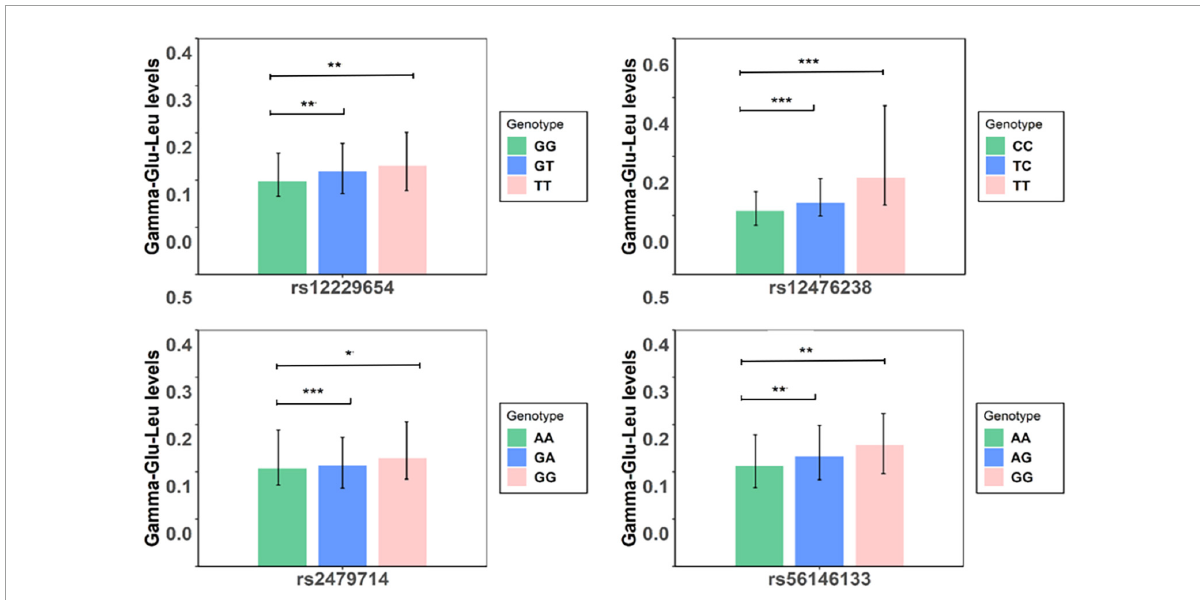
FIGURE2 Serum levels of Gamma-glutamyl-leucine (Gamma-Glu-Leu) in subjects with different genotypes ( N = 1,062). Symbol *denotes that serum levels of Gamma-Glu-Leu were significantly different between groups. *** P -value < 0.001;** P -value < 0.01; * P -value <